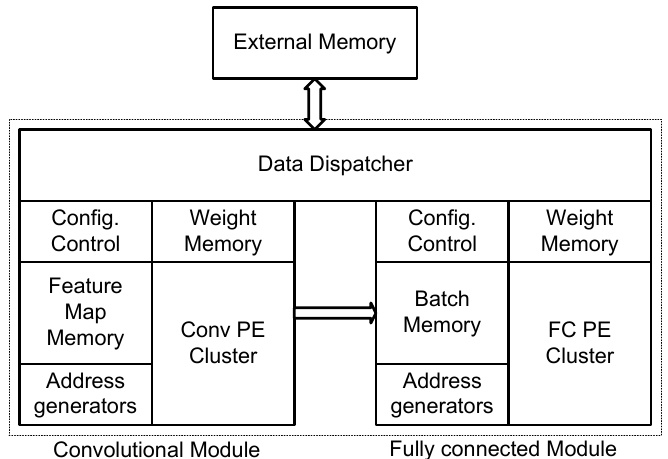
Figure 1. Block diagram of the proposed